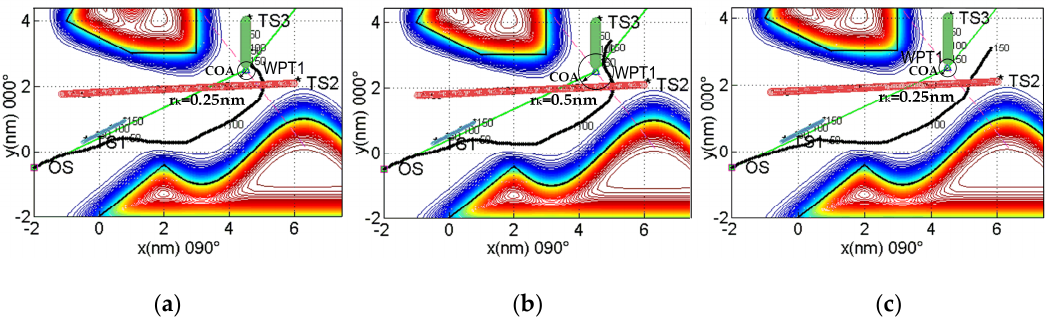
Figure 19. Comparison of dynamic path planning results for different values of r k with or without the angular bisector method. ( a ) r k = 0.25 nm without using the angular bisector method; ( b ) r k = 0.5 nm without using the angular bisector method; and ( c ) r k = 0.25 nm using the angular bisector method.